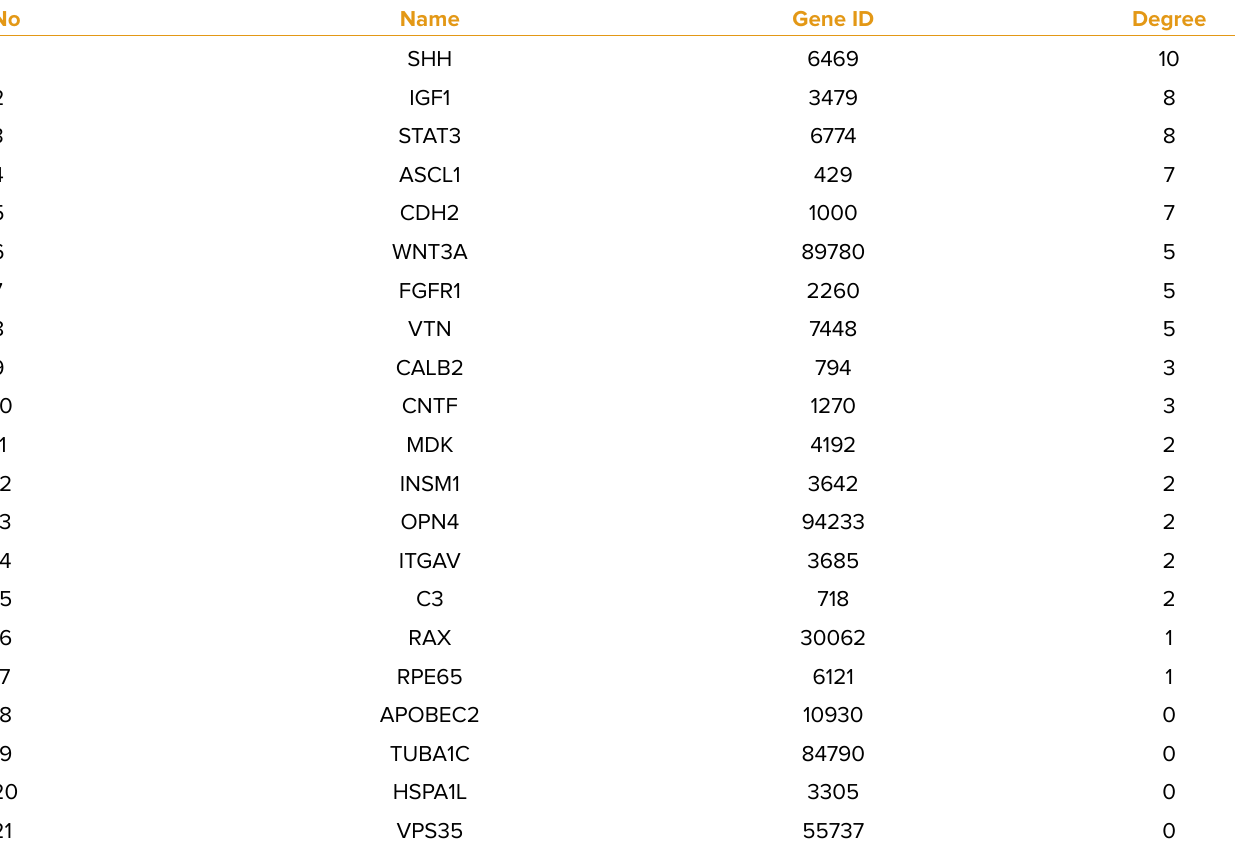
Table 1. The list of protein-coding genes that are involved in retinal regeneration